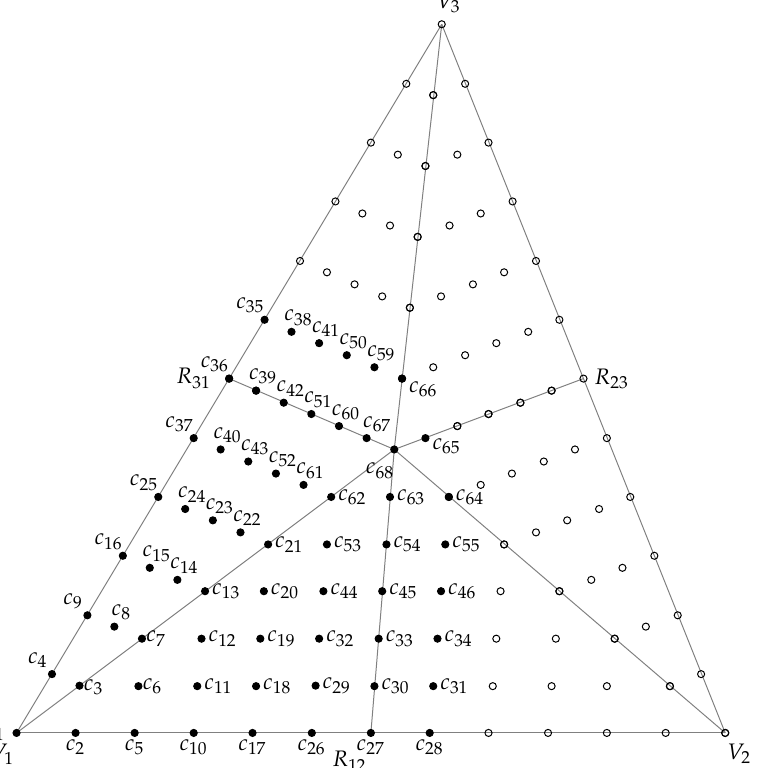
Figure 3. Representation of the Bézier ordinates of a B-spline relative to a vertex. The BB-coefficients that are known to be zero are indicated by open ◦ .